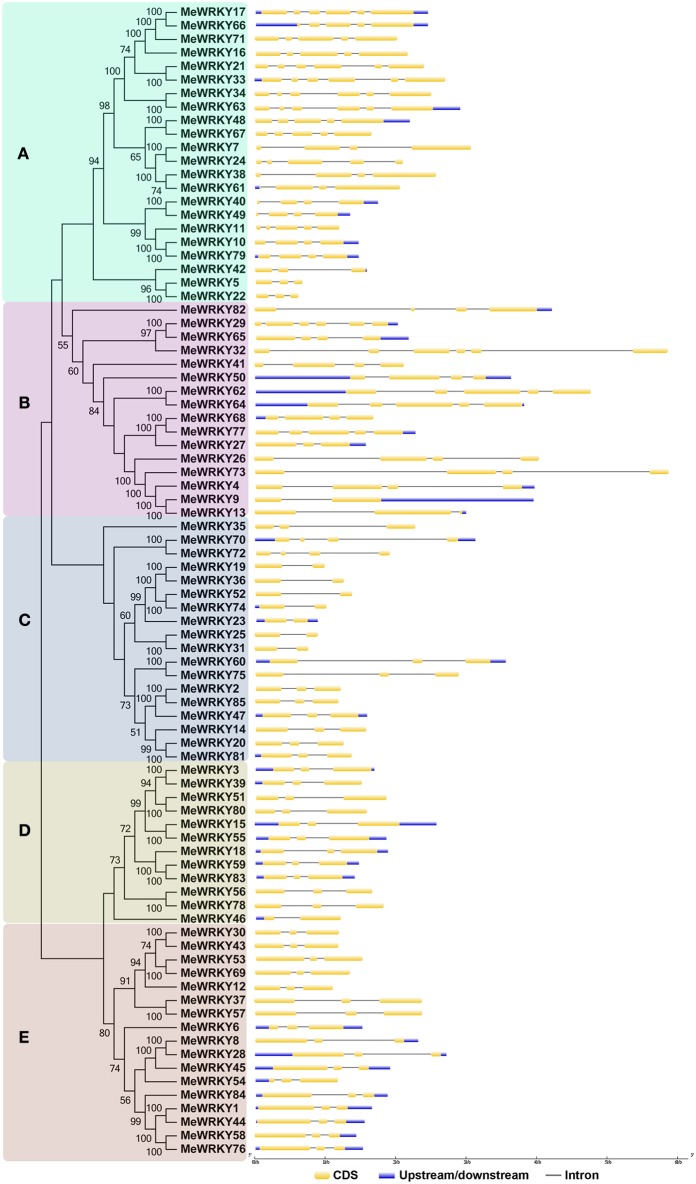
The exon-intron structure of MeWRKY genes according to the phylogenetic relationship. The unrooted phylogenetic tree was constructed based on the full length sequences of MeWRKYs with 1000 bootstraps. Exon-intron structure analyses of MeWRKY genes were performed by using the online tool GSDS. Lengths of exons and introns of each MeWRKY gene were exhibited proportionally. (A–E) indicates different groups of WRKY family in cassava.